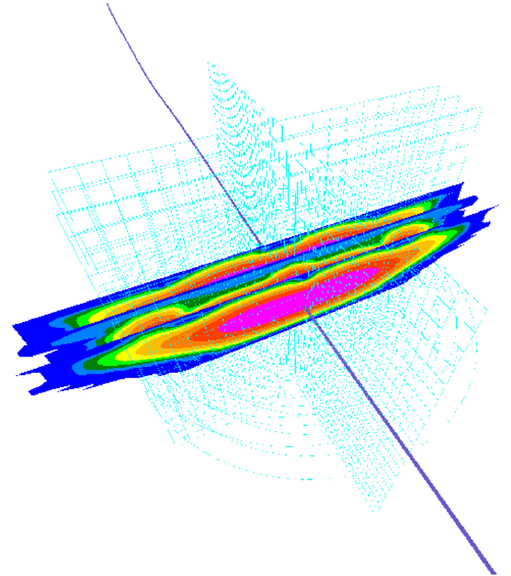
Figure 2. The hydraulic-fracture morphology in a single fracturing section.